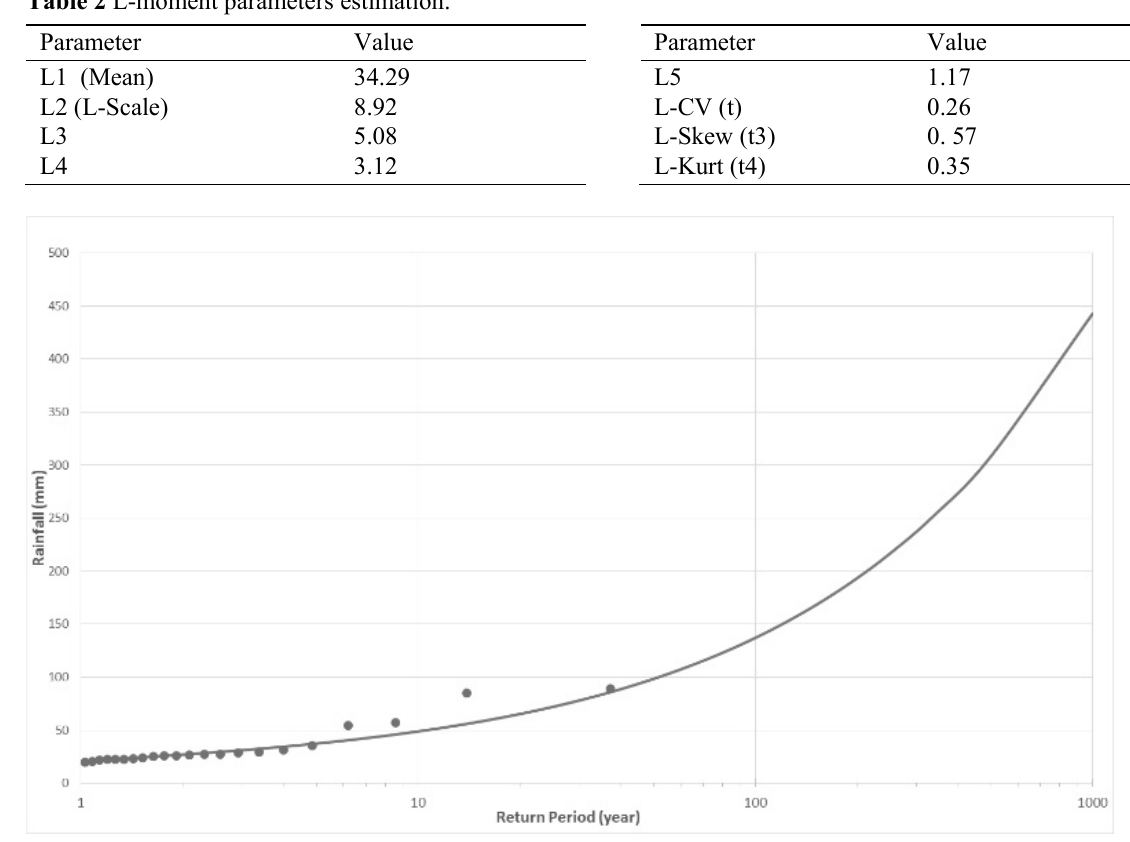
Table 2 L-moment parameters estimation.